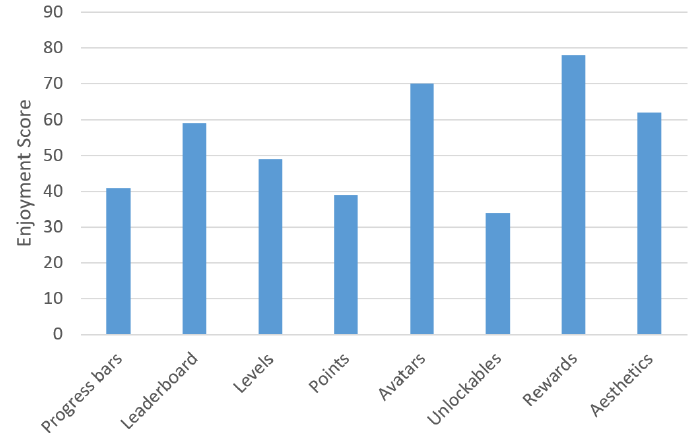
Figure 15. Enjoyment score for each game